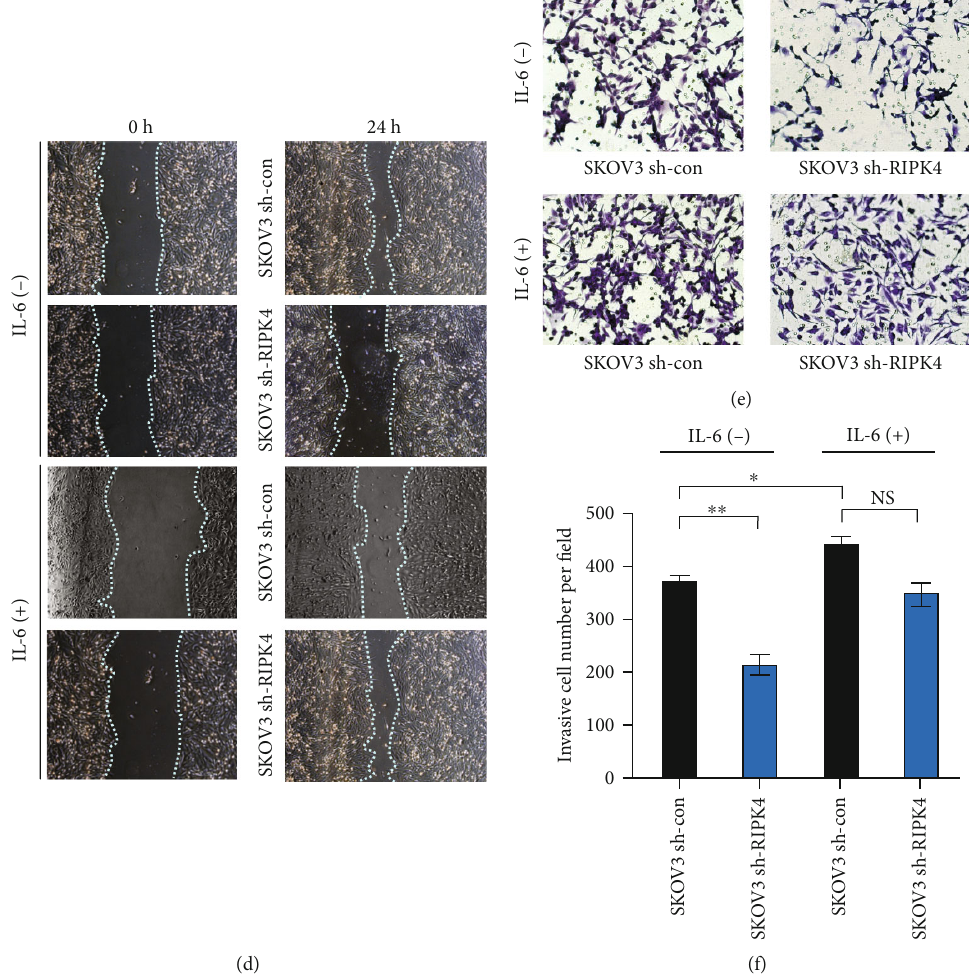
Figure 5: RIPK4 a ff ects the IL-6/STAT3 axis in OC, and IL-6 promotes SKOV3 migration and rescues the mobility of RIPK4-silenced cells. (a) RT-PCR results show that the levels of IL-6 target genes and EMT biomarkers are downregulated in RIPK4-silenced OC cell lines compared with control cell lines. The results are shown as the mean ± SD ( n = 6 per group). (b) ELISA analysis shows that the IL-6 levels in the supernatants of RIPK4-silenced OC cell cultures were signi fi cantly lower than those in control culture supernatants ( P = 0 : 036 ). (c and d) The e ff ects of adding IL-6 (50 μ g/ml) to SKOV3-sh-RIPK4-silenced and control OC cells were detected with wound healing assays. IL-6 signi fi cantly promoted migration by SKOV3-sh-RIPK4-control cells ( P = 0 : 018 ). (e and f) Additionally, IL-6 rescued the migratory ability of SKOV3-sh-RIPK4-silenced cells ( P = 0 : 051 ). The ratio of gap disappearance and the invasive cell number is shown. ∗∗ P < 0 : 01 vs. control (unpaired t -test). ∗ P < 0 : 05 vs. control (unpaired t